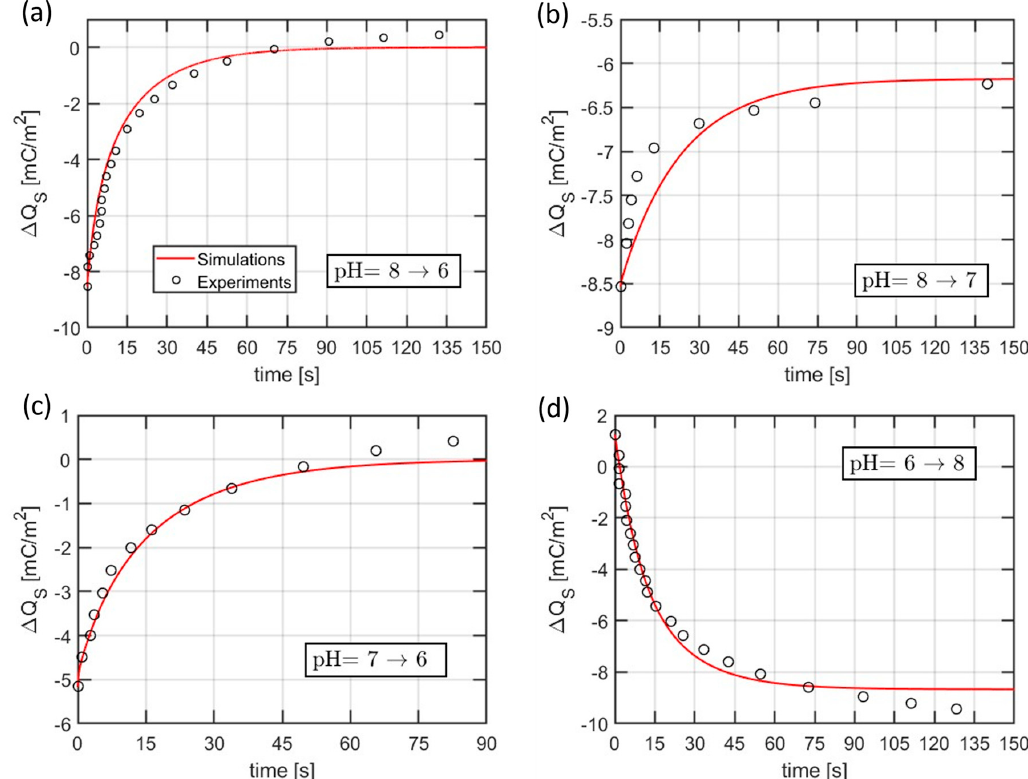
Figure 10. Model calibration from experimental data in terms of transient surface charge changes upon pH step. The experimental data are taken from the current transients in Figure 9 and are scaled using an arbitrary linear relationship between surface charge and drain current. The values of the employed time constants τ a and τ b are, respectively, 9.5 and 7 s.